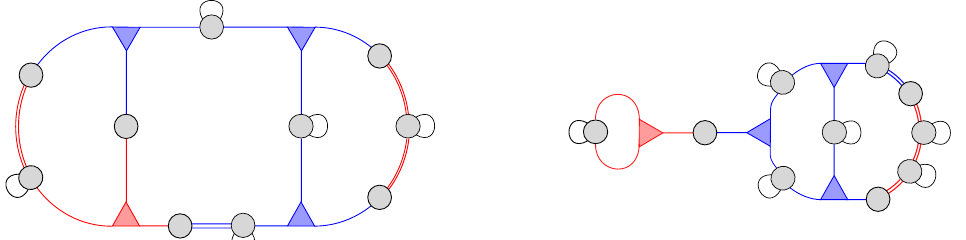
Figure 7 . All quivers with g = 1 , n = 6 , z = 0 and (cid:17) = 1 Seiberg dualities.